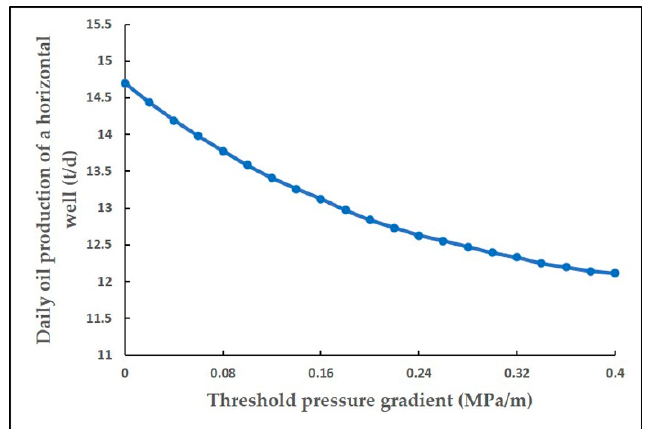
Figure 10. The influence of threshold pressure gradient on horizontal well production.